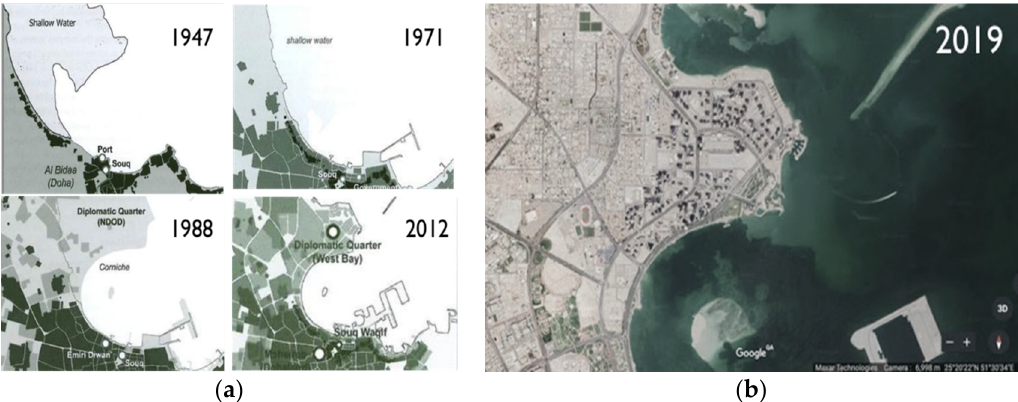
Figure 2. ( a ) Urban pattern throughout the history (source: Adapted from [21]) ( b ) current urban pattern 2019 (Source: google earth).